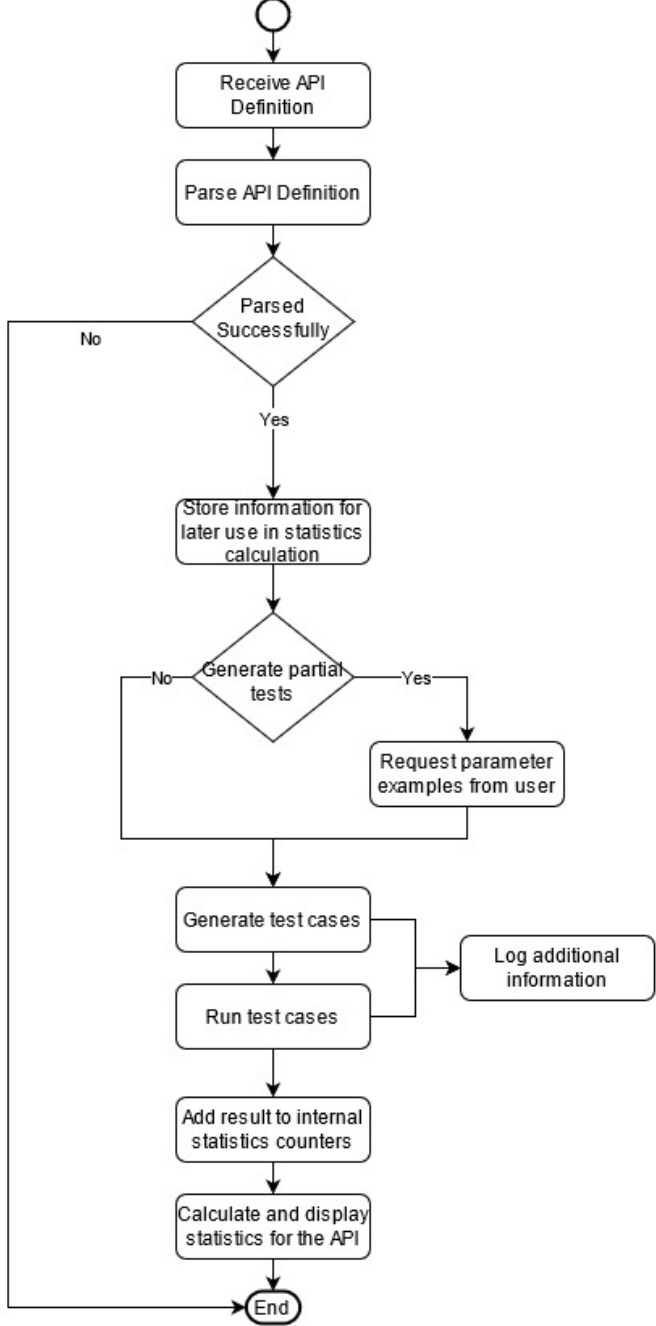
Figure 3. System activities and actions (activity diagram).